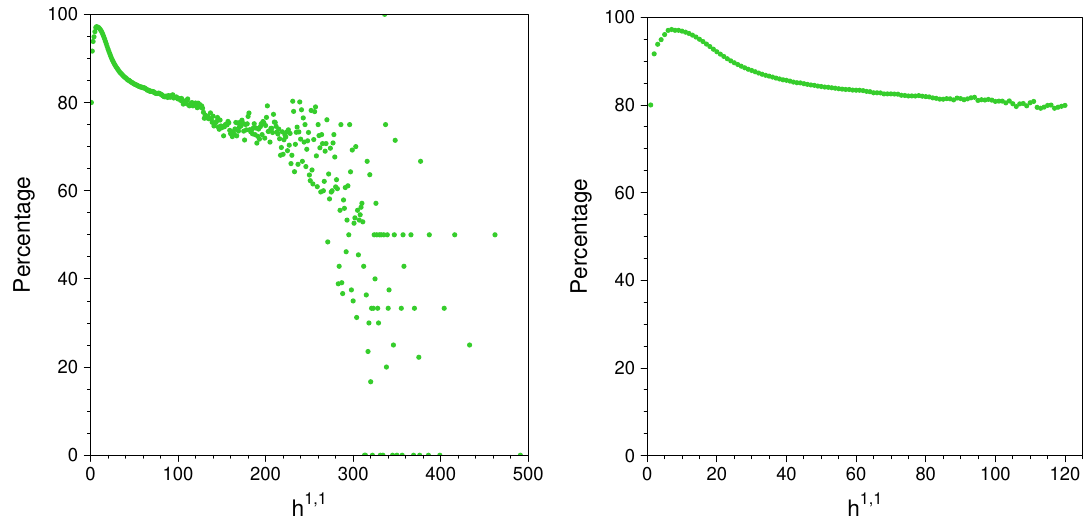
Figure 4 . (Left) The percentage of dual polytopes that contain S3S at each h 1 ; 1 value. (Right) The same graph, truncated at h 1 ; 1 (cid:20) 120. We note that the erratic portion of the (cid:12)gure 4 for h 1 ; 1 > (cid:24) 120 accounts for fewer than 1 million polytopes. The truncated graph ((cid:12)gure 4b) shows more clearly the prevalence of S3S.